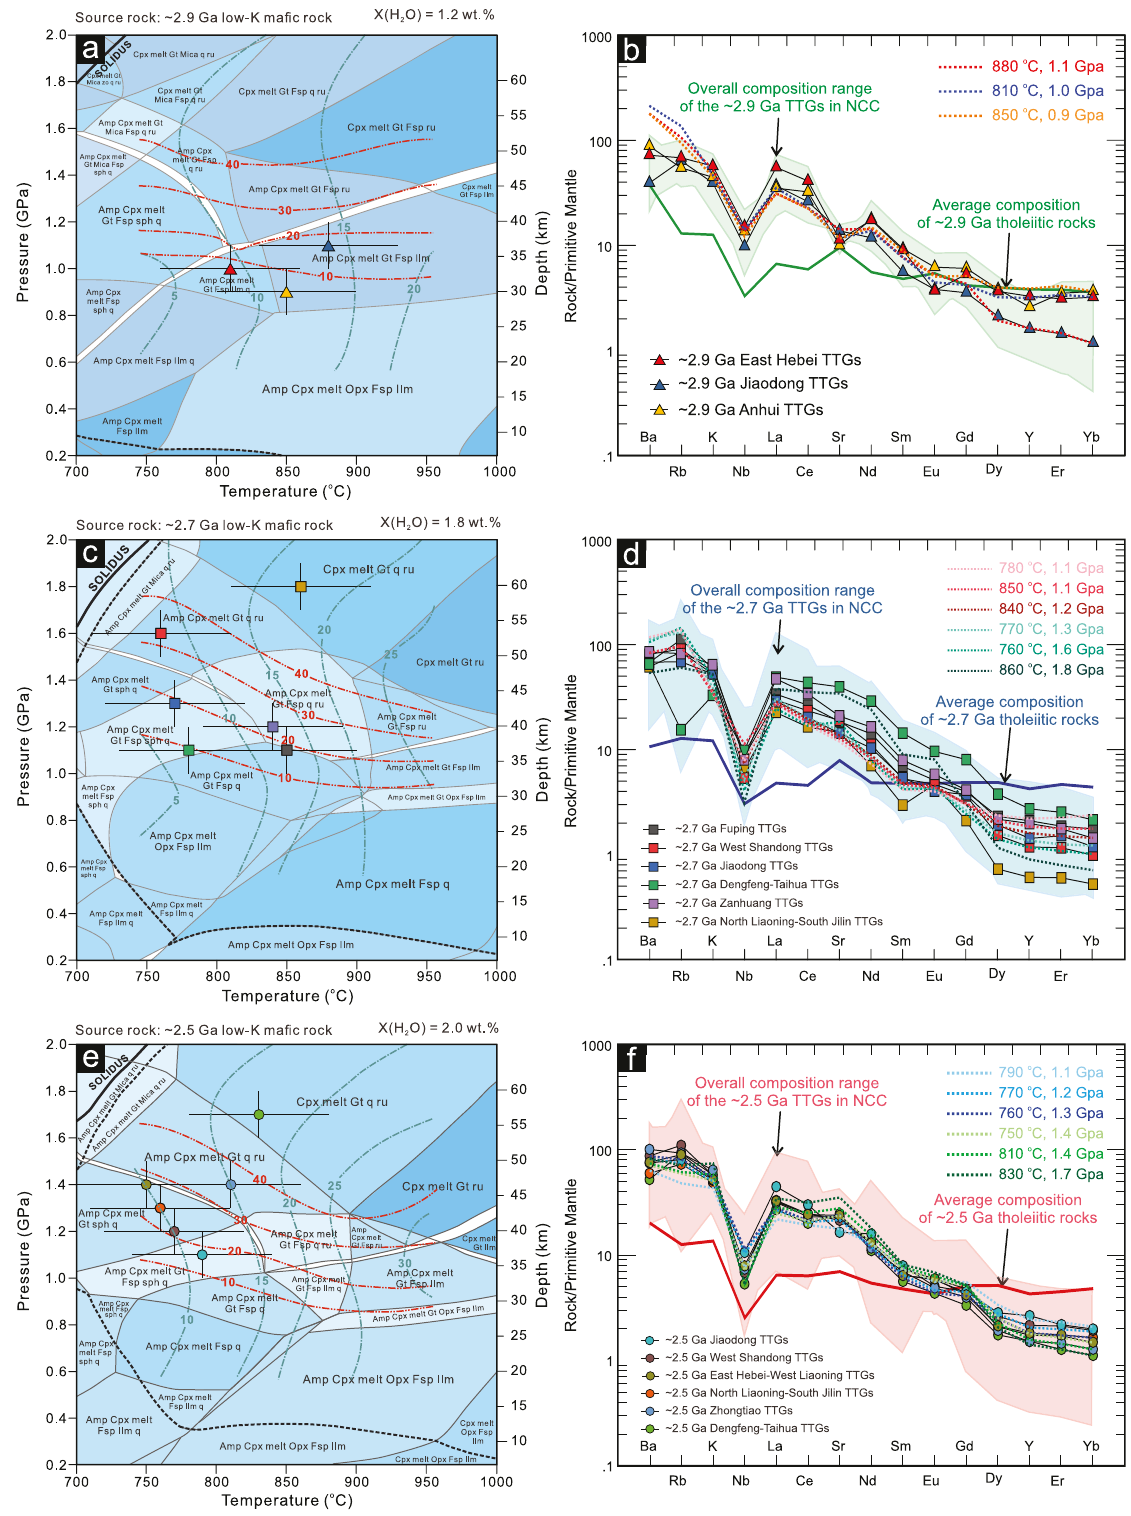
Fig. 3 Thermodynamic and trace element modelling. a , c , e Simpli fi ed P – T phase diagram for the average composition of ~2.9 Ga, ~2.7 Ga and ~2.5 Ga low-K tholeiitic rocks from the Eastern Block of the North China Craton, calculated with water contents of 1.2, 1.8 and 2.0 wt.%, respectively, corresponding to dehydration melting of metamorphosed ma fi c rocks. Green and red dashed lines show calculated degree of melting (wt.% of melt) and garnet proportion (%) in residue, respectively, black dotted lines mark water saturation of the system; b , d , f Trace element patterns of TTG melts calculated at different P – T – X(H 2 O) conditions for the average composition of Meso- to Neoarchean low-K tholeiitic rocks. The pale green, blue and pink shaded areas indicate the overall compositional range of the ~2.9 Ga, ~2.7 Ga and ~2.5 Ga TTG melts, respectively.